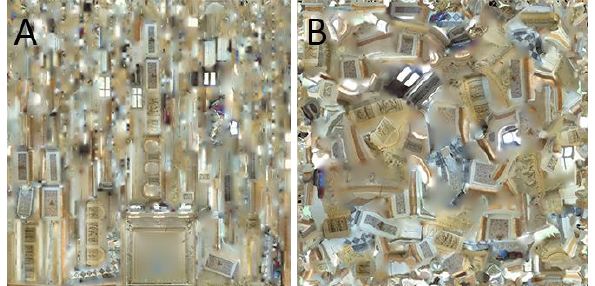
Figure 2. Textures in adaptive orthophoto (A) and generic (B) mapping mode.